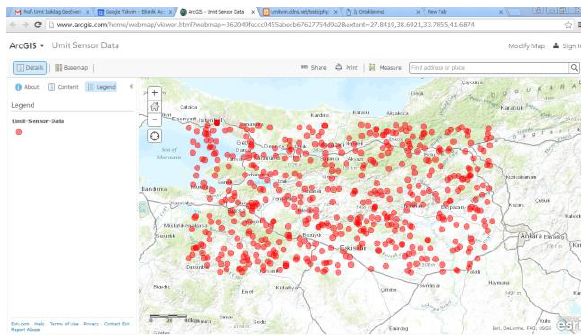
Figure 9: Representation of real-time information acquired from IoT Nodes in ArcGIS